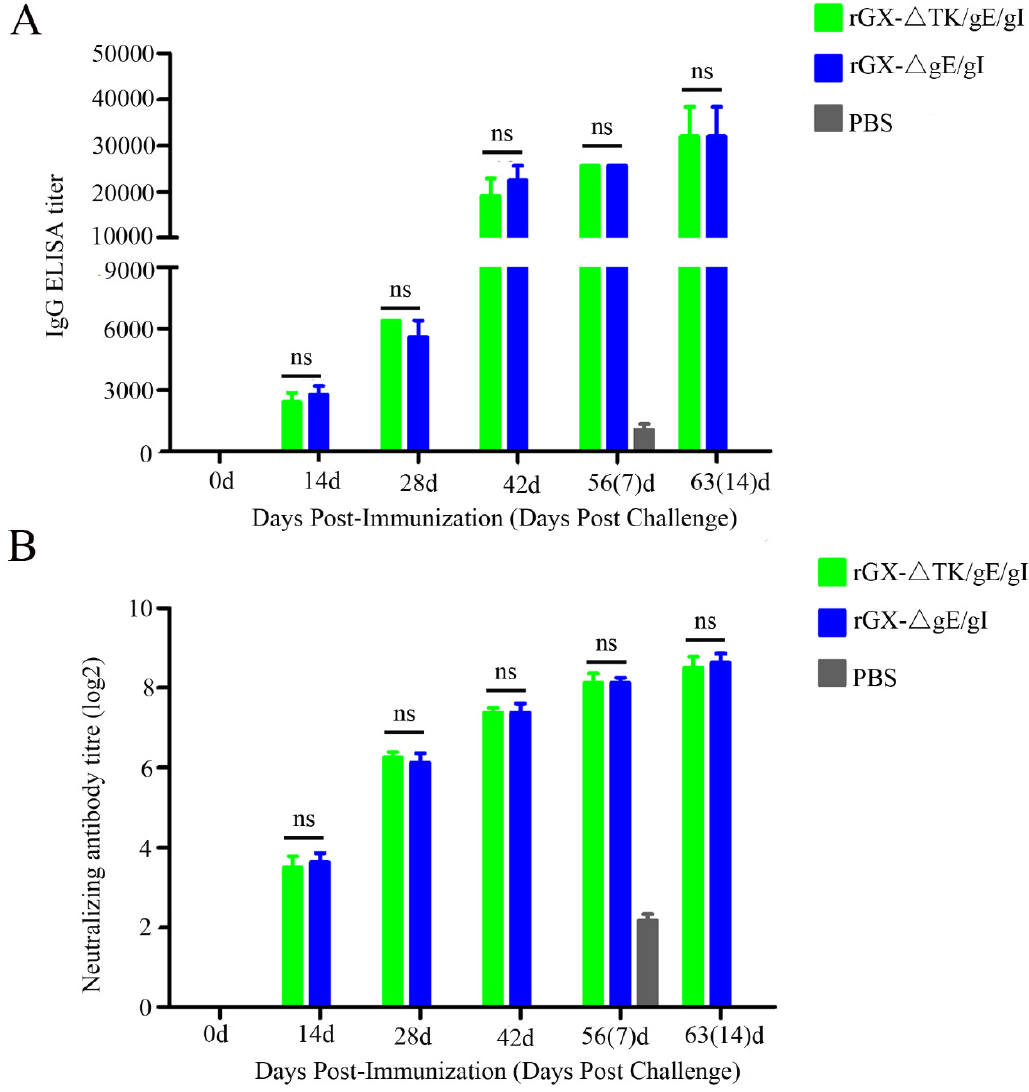
Figure 5. PRV-gD-specific IgG titre and neutralizing antibody titre were evaluated. ( A ) The indirect ELISA was used to detect gD-specific IgG titer from serum samples at 0, 14, 28, 42, 56, and 63 dpi. ( B ) Neutralizing antibody titer was examined in the serum of the immunized pigs. The neutralizing ability of antisera generated against PRV-GX strain was calculated and presented as the log2 of the reciprocal of the highest serum dilution when PK-15 cell infection was inhibited. n = 4. ns represents not significant.